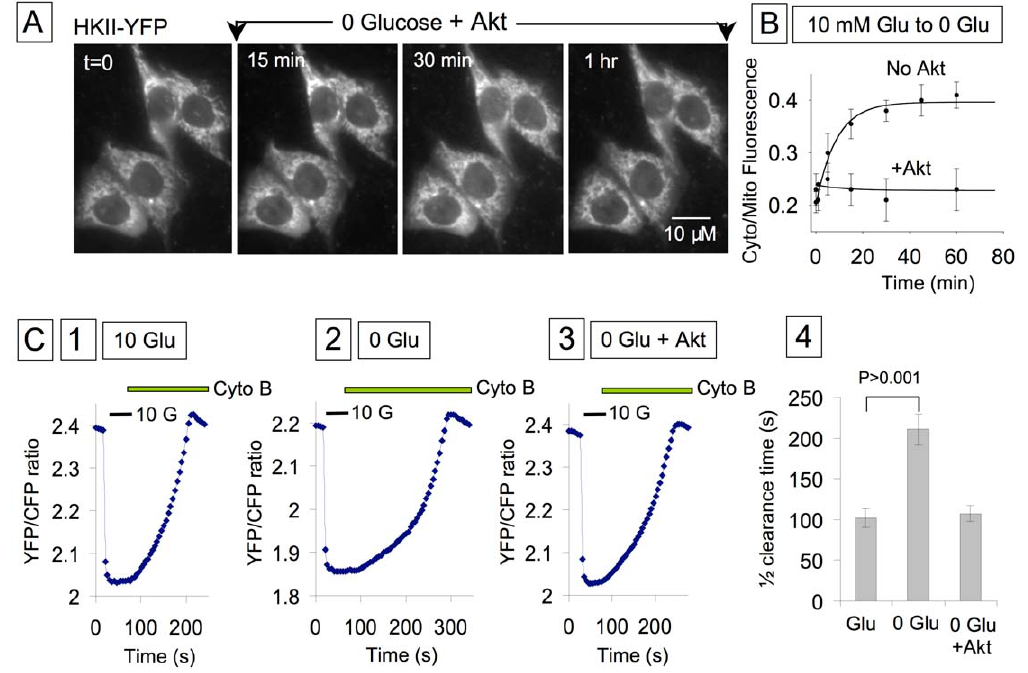
Figure 7. Constitutively active Akt prevents the effect of glucose removal on HKII dissociation from mitochondria. Images in (A) obtained with overexpression of a constitutively active Akt illustrate how Akt prevents HKII dissociation evoked by removal of glucose. Panel B shows a quantification of this effect, comparing the rate of HKII dissociation from mitochondria in response to glucose removal in the presence and absence of exogenous Akt. Data in Panel C show how glucose clearance is affected by preincubation in the absence of glucose and how constitutively active Akt prevents this effect. Previous data (Fig. 6B) have shown that HKII dissociates from mitochondria 15 to 30 min after removal of extracellular glucose; comparison of traces C1 and C2 (in C2 cells were incubated for 30 min in the absence of glucose) indicates that this effect is accompanied by a decrease in glucose clearance. Thus, glucose-induced HK dissociation slows the rate of glucose utilization. The recording in C3 obtained with cells overexpressing constitutively active Akt indicates that Akt prevents the decrease in glucose clearance induced by incubation in the absence of glucose for 30 min. This effect is very likely related to the effect of Akt on HKII translocation. The bar graph in C4 quantifies the effects of glucose removal and Akt on glucose